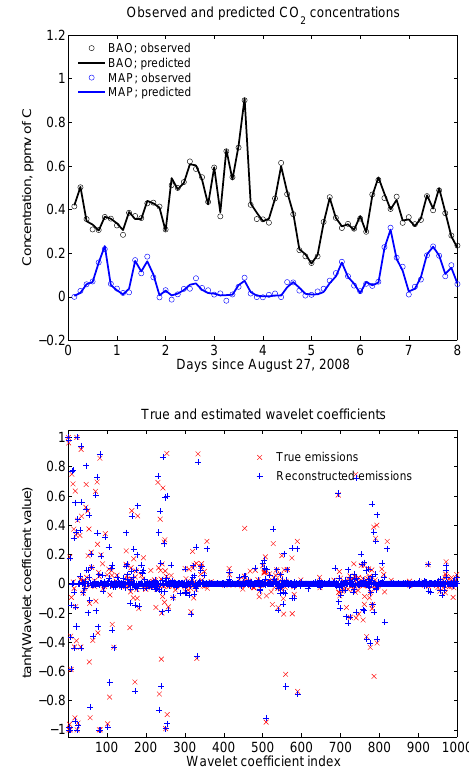
Figure 6. (Top) predictions of ffCO 2 concentrations at two measurement locations, using the true (Vulcan) and reconstructed emissions (blue lines) over an 8-day period (period no. 31). Observations occur every 3h. We see that the concentrations are accurately reproduced by the estimated emissions. (Bottom) Projection of the true and estimated emissions on the wavelet bases for the same period. Coarse wavelets have lower indices, and they progressively get finer with the index number. We see that the true emissions have a large number of wavelets with small, but not zero, coefficients. In the reconstruction (plotted in blue), a number of wavelet coefficients are set to very small values (almost zero) by the sparse reconstruction. The larger scales are estimated accurately.